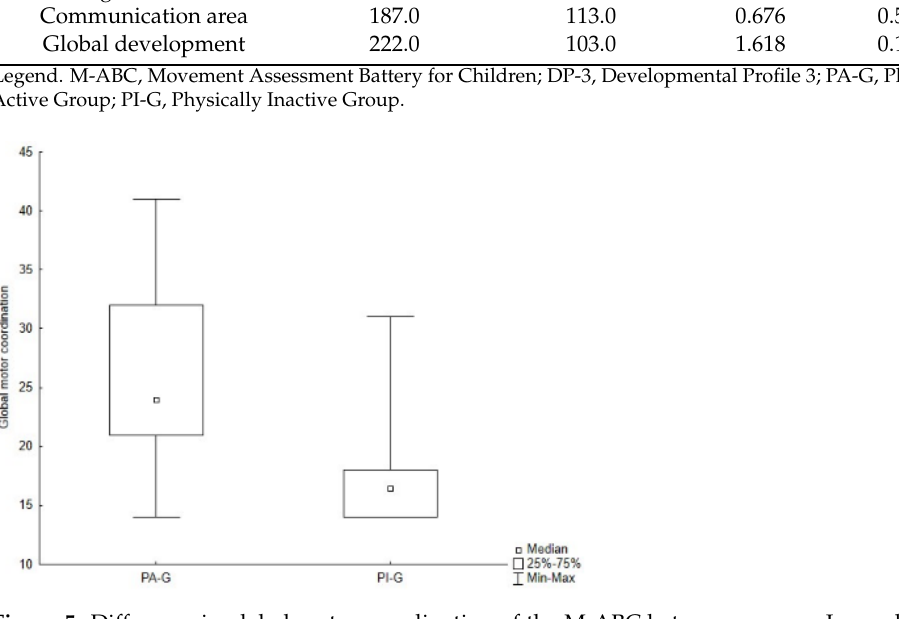
Figure 5. Difference in global motor coordination of the M-ABC between groups. Legend. PA-G, Physically Active Group; PI-G, Physically Inactive Group.